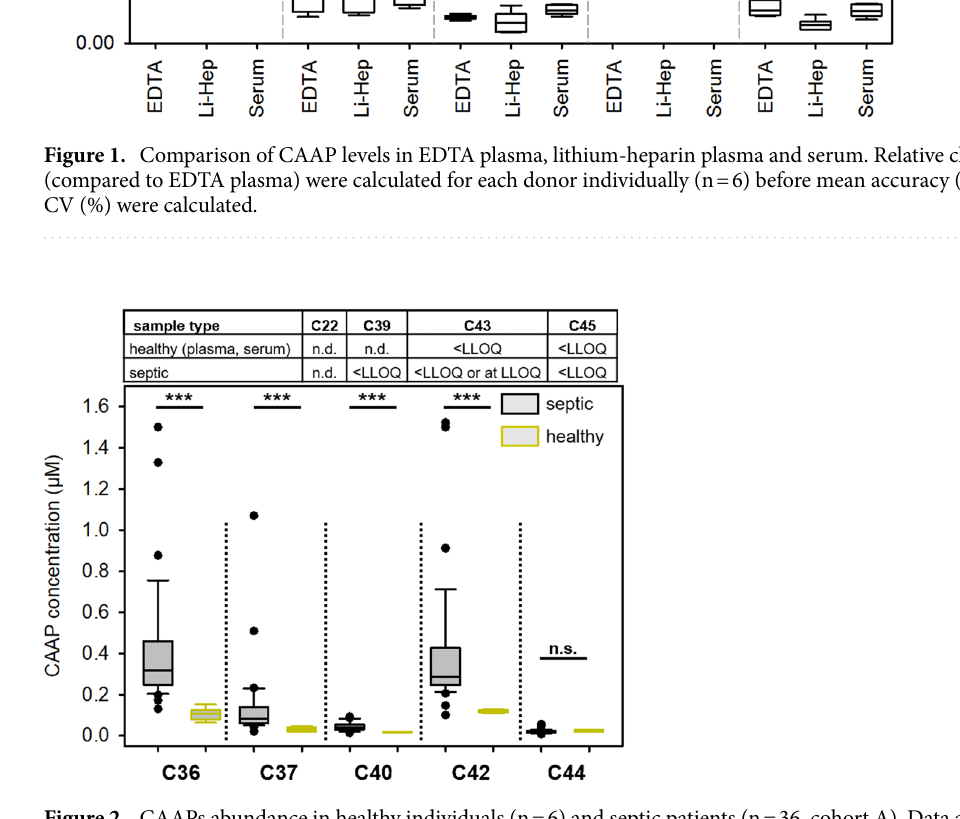
Figure 2. CAAPs abundance in healthy individuals (n = 6) and septic patients (n = 36, cohort A). Data are based on measurements of EDTA plasma samples, which were obtained from patients within the first three days after onset of sepsis. Statistical analysis was conducted using Mann–Whitney Rank Sum Test. *** P < 0.001, n.d. not detected, n.s. not